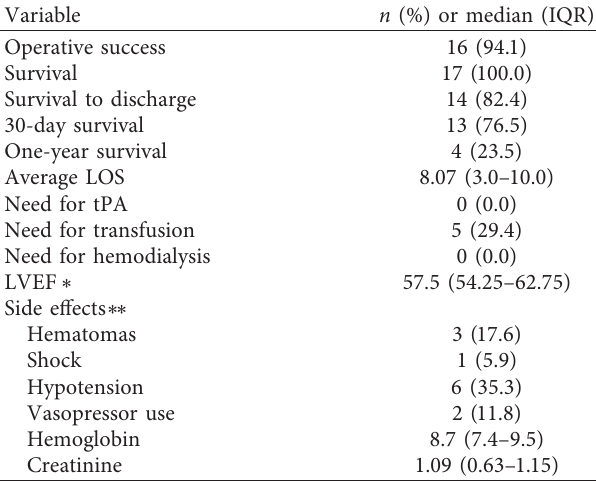
Table 3: Postoperative